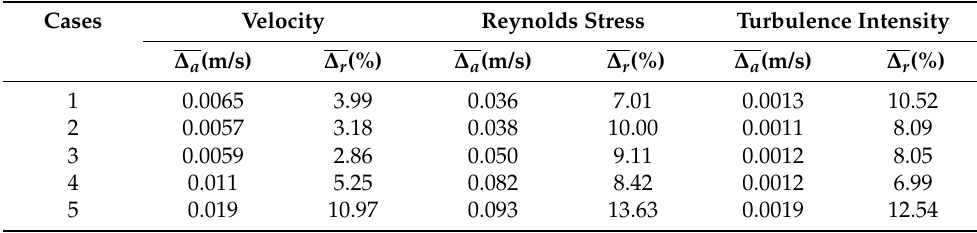
Figure 6. Comparison of the measured and analytical turbulence intensity. Black squares denote the measured data and red lines denote the analytical ones. Table 2. Error statistics for the longitudinal velocity, Reynolds stress and turbulence intensity. ∆ a is the average absolute error and ∆ r is the average relative